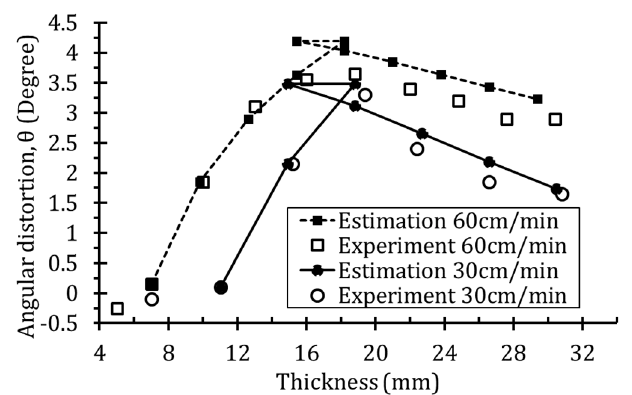
Figure 15. Comparison of experimental and predicted values of 28 t X butt welding.